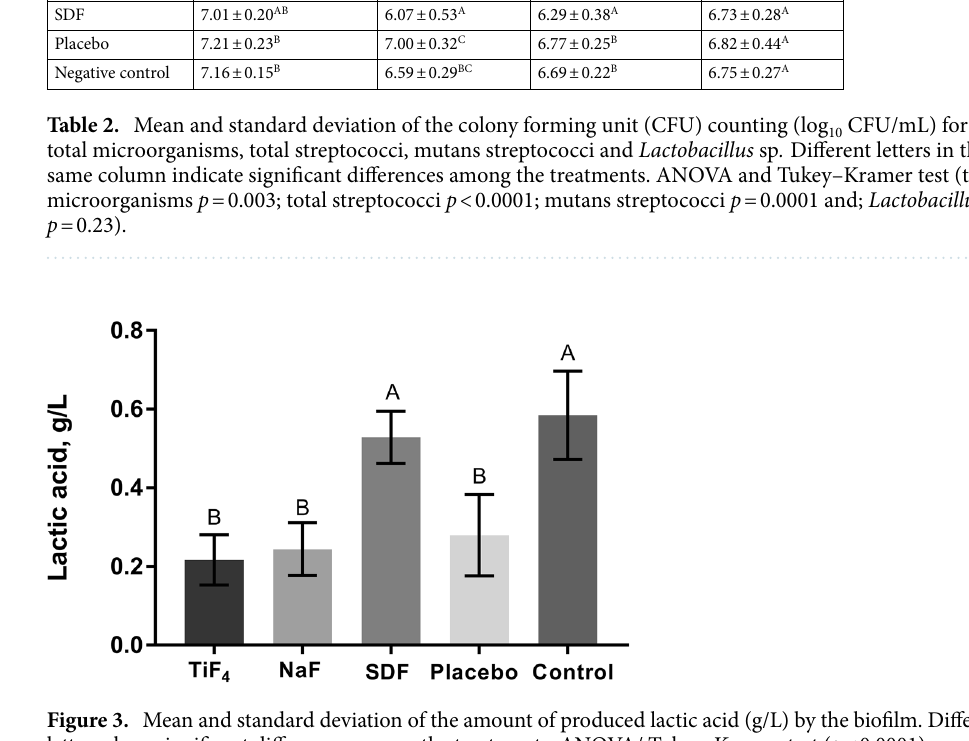
Figure 3. Mean and standard deviation of the amount of produced lactic acid (g/L) by the biofilm. Different letters show significant differences among the treatments. ANOVA/ Tukey–Kramer test ( p <